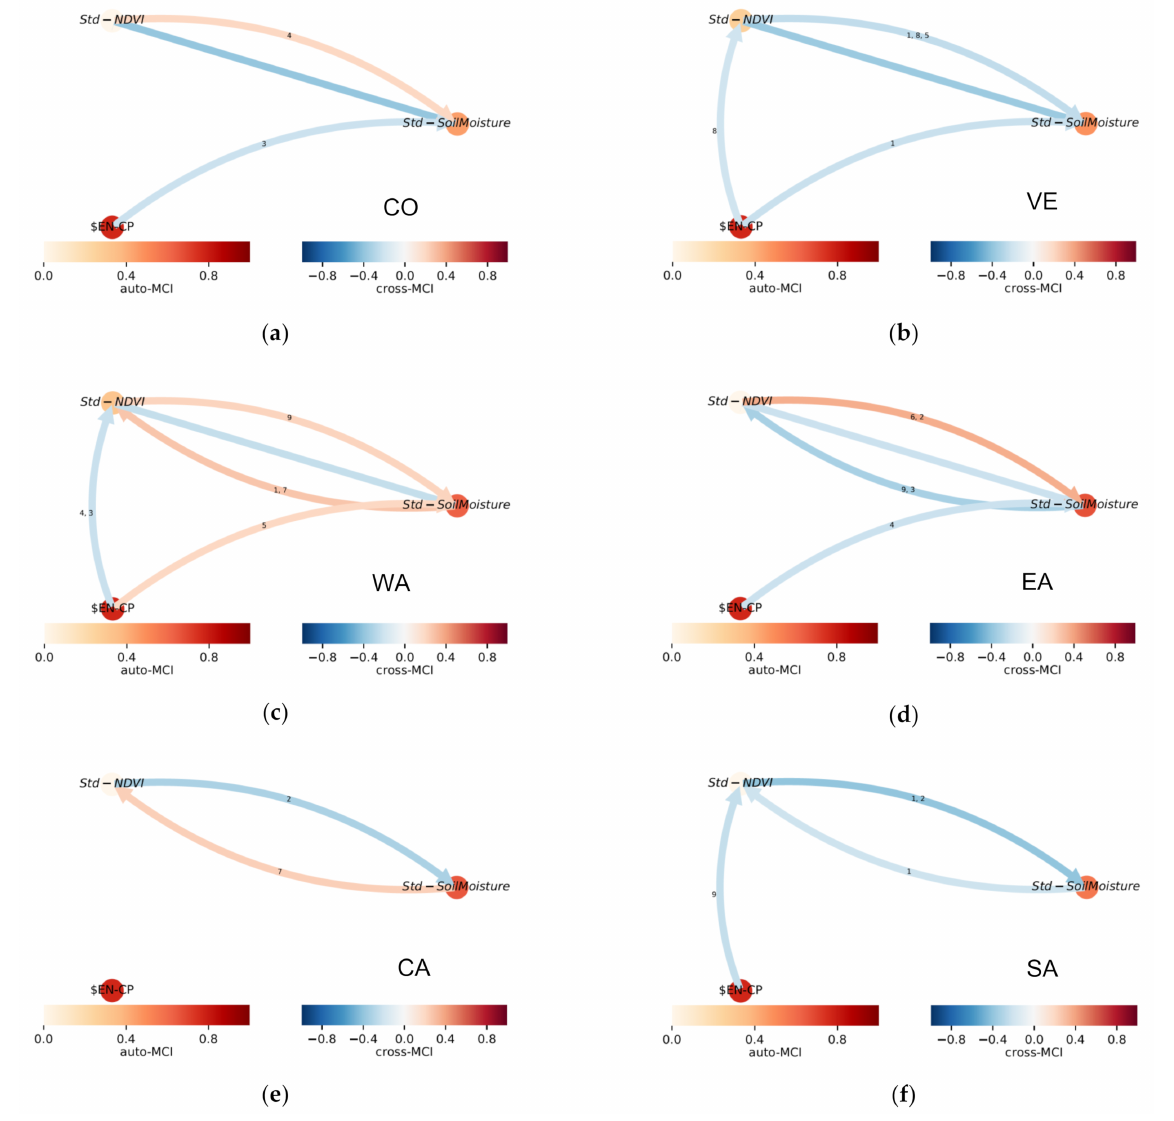
Figure 11. Nonlinear causality analysis based on ParrCorr between the standardized monthly series of NDVI and SMOS, and the Central Pacific (CP) index. Node colors denote the nonlinear auto-dependency of each variable, whereas the colors of the lines denote the cross-MCI between both variables and the horizontal lines denotes the simultaneous nonlinear co-dependency. ( a ) CO: Colombia, ( b ) VE: Venezuela, ( c ) WA: West Amazonia, ( d ) EA: East Amazonia, ( e ) CA: Center Amazonia, and ( f ) SA: South